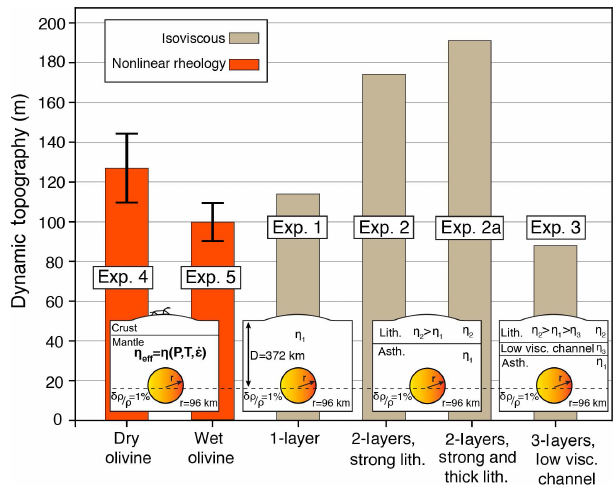
Figure 8. Predicted dynamic topographies driven by a rising sphere centred at 372km depth with 96km radius and 1% less dense than the ambient mantle. The various experiments differ by rheology (isoviscous vs. nonlinear) and viscous structure. For experiments 4 and 5, we show variation in dynamic topography due to contrasting activation energy. In general, experiments with nonlinear rheologies having up to 3 orders of magnitude variation in viscosity generally predict lesser magnitudes of dynamic topography compared to ex- periments using isoviscous rheology. Compared to dry olivine, wet olivine rheology results in lower dynamic